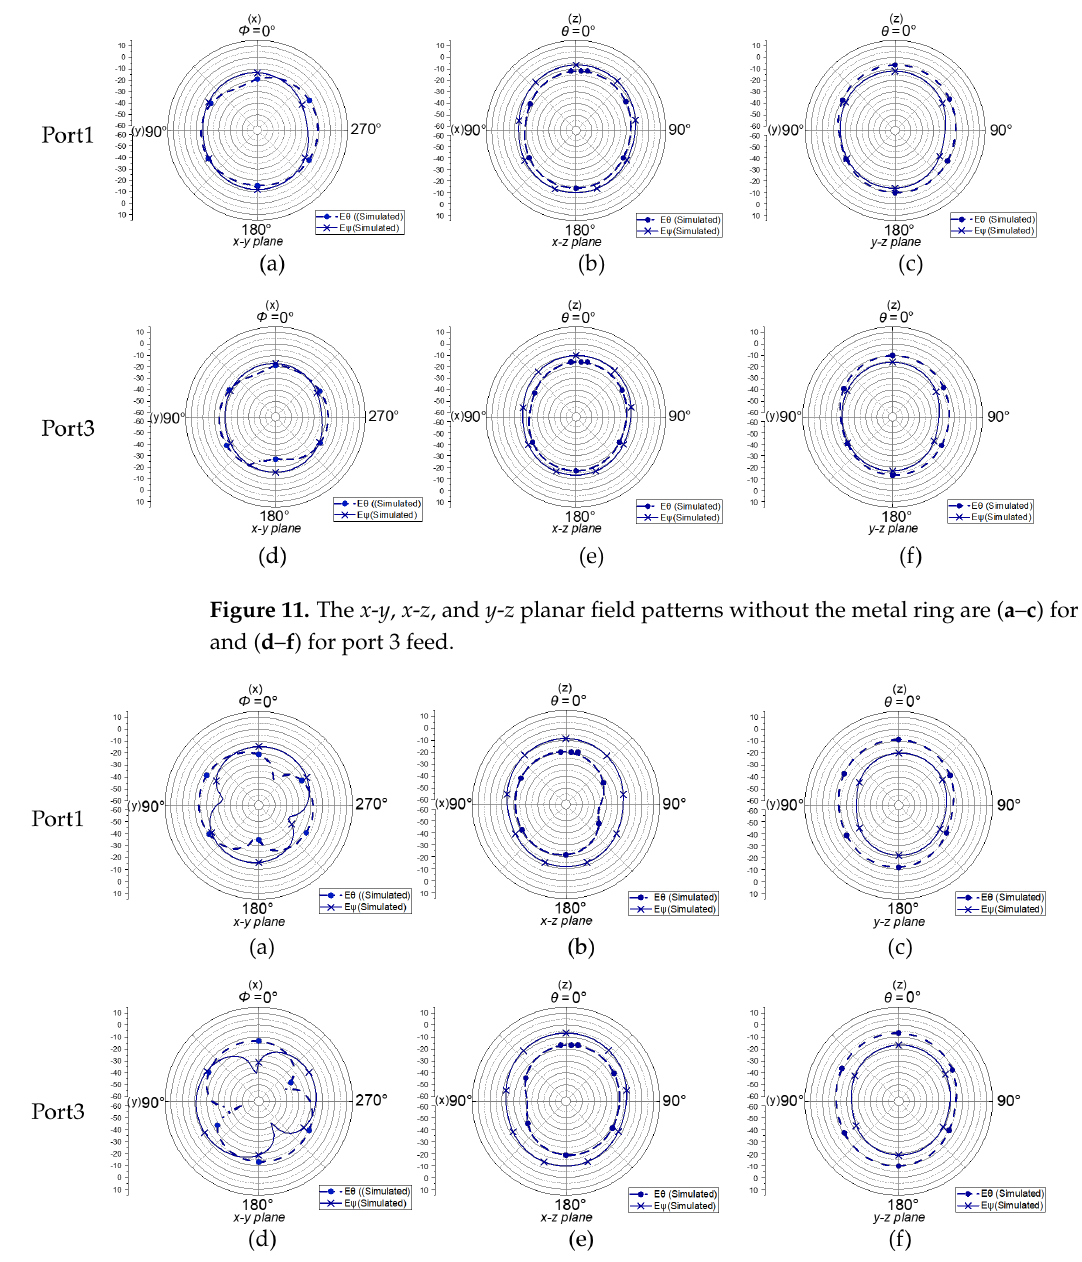
Figure 12. Adding the x - y , x - z , and y - z plane field patterns of the metal ring, ( a – c ) for port 1 feed and ( d – f ) for port 3 feed.